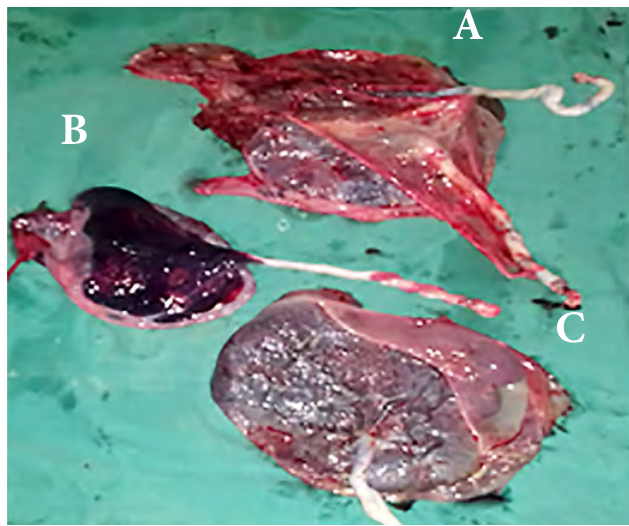
Fig 1 : A. Placenta of 1 st and 4 th quadruplets B. Placenta of 3 rd qua- druplet C. Placenta of 2 nd quadruplet (color picture available online )